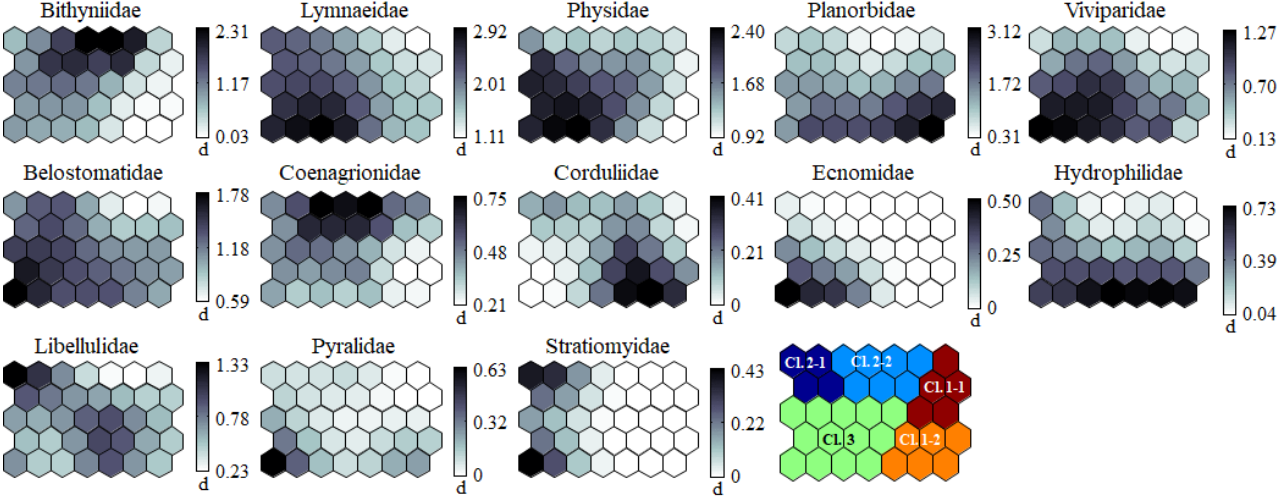
Figure 4. Component map of 24 invertebrate groups. Each band shows the abundance of each invertebrate, transformed by a natural logarithm.